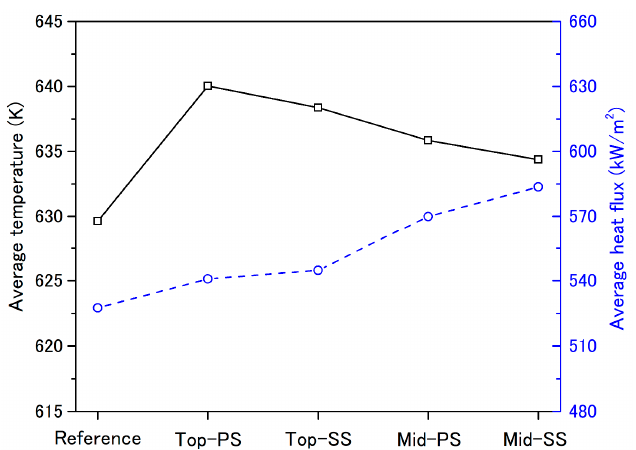
Figure 16. Average temperature and heat flux on the R 1 blade tip under different damaged-blade conditions.